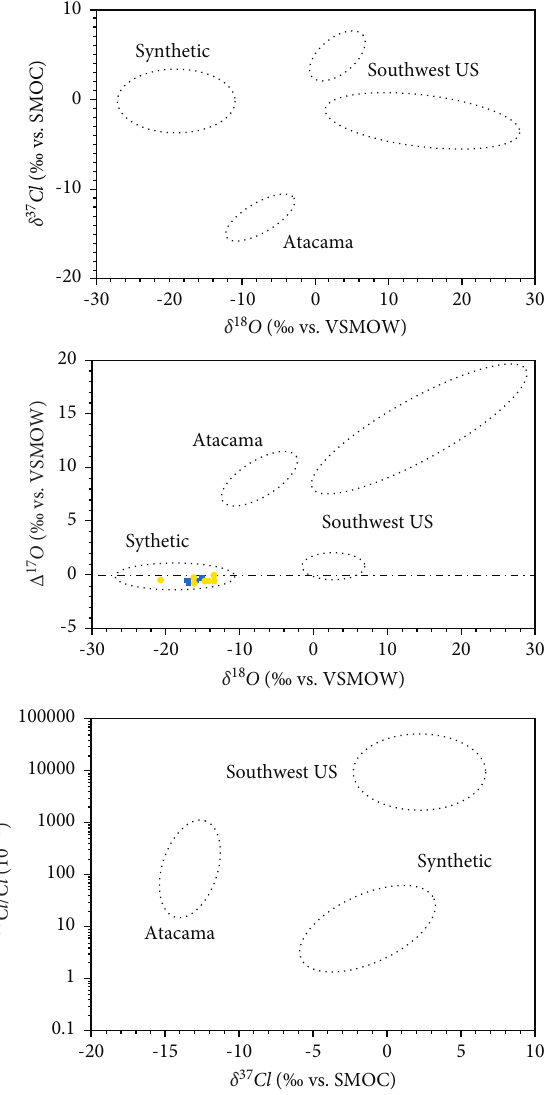
Figure 2: δ 37 Cl (‰) versus δ 18 O (‰) values (upper diagram) and Δ 17 O (‰) versus δ 18 O (‰) values (middle diagram) for samples of synthetic ClO 4 − , Atacama ClO 4 − , and southwest ClO 4 − . Southwest ClO 4 − is subdivided into southern SHP and DV [31, 32, 34]. 36 Cl/Cl versus δ 37 Cl (‰) values (bottom diagram) for samples of synthetic ClO 4 − , Atacama ClO 4 − , and Southwest ClO 4 − [42]. The colored points represent the isotope value of some analytical reagents and firework samples measured by the authors (purple points: KClO 4 , CsClO 4 , NaClO 4 , RbClO 4 , and Mg(ClO 4 ) 2 and blue points: firework samples).